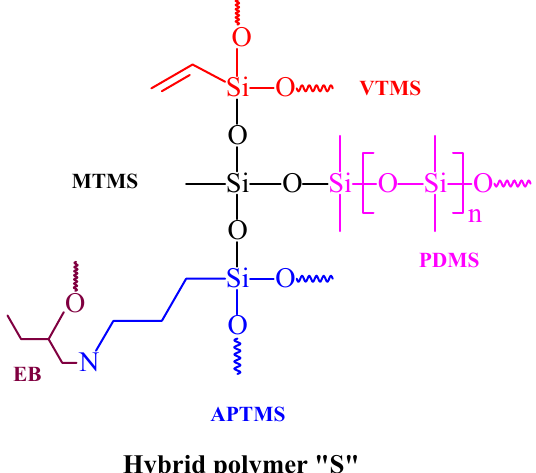
Figure 1. Proposed sol–gel networks in the hybrid polymer